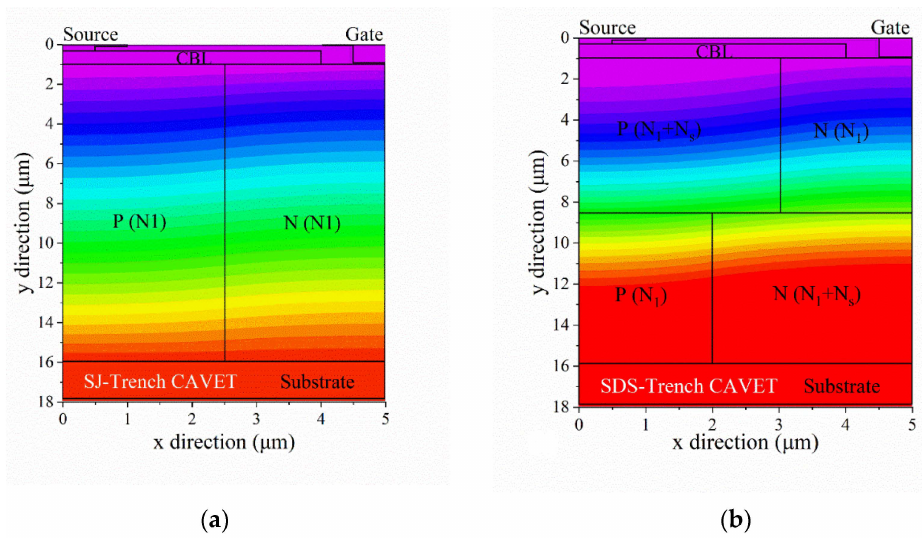
Figure 7. Off-state performance of ( a ) SJ-Trench CAVET compared with ( b ) SDS-Trench CAVET according to potential equipotential surface.